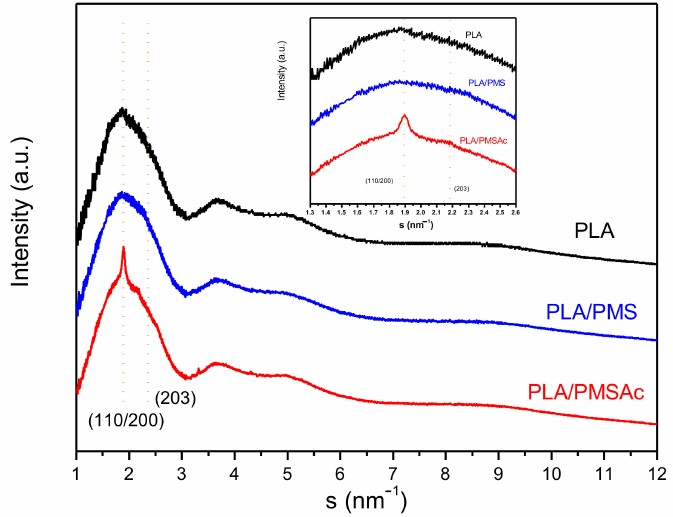
Figure 5. Wide-angle X-ray diffraction patterns of the PLA, PLA/PMS, and PLA/PMSAc fibers. The α form of the PLA, a pseudo-orthorhombic structure with each unit cell containing two 10 3 helical chains, presented a similar chain conformation to the α (cid:48) form, but, in this case, it was more disordered. In the pattern, we can distinguish a clear reflection at 1.86 nm − 1 (110/200) and diffuse (203) at 2.12 nm − 1 , which can be attributed to both forms. The α -form is obtained by isothermal crystallization above 120 ◦ C or by stretching a solution-spun PLA fiber at relatively low drawing temperatures and/or low hot-draw ratios [30]. The α (cid:48) -form crystals are developed by melt or cold crystallization at lower temperatures (below 100 ◦ C), and a mixture of α - and α ’-form crystals is formed in the intermediate temperature region between 100 and 120 ◦ C [31,32]. The diffraction profiles of α and α (cid:48) forms are quite different at q values of >15 nm − 1 [33,34]. In the present work, the crystalline fractions did not allow us to distinguish between